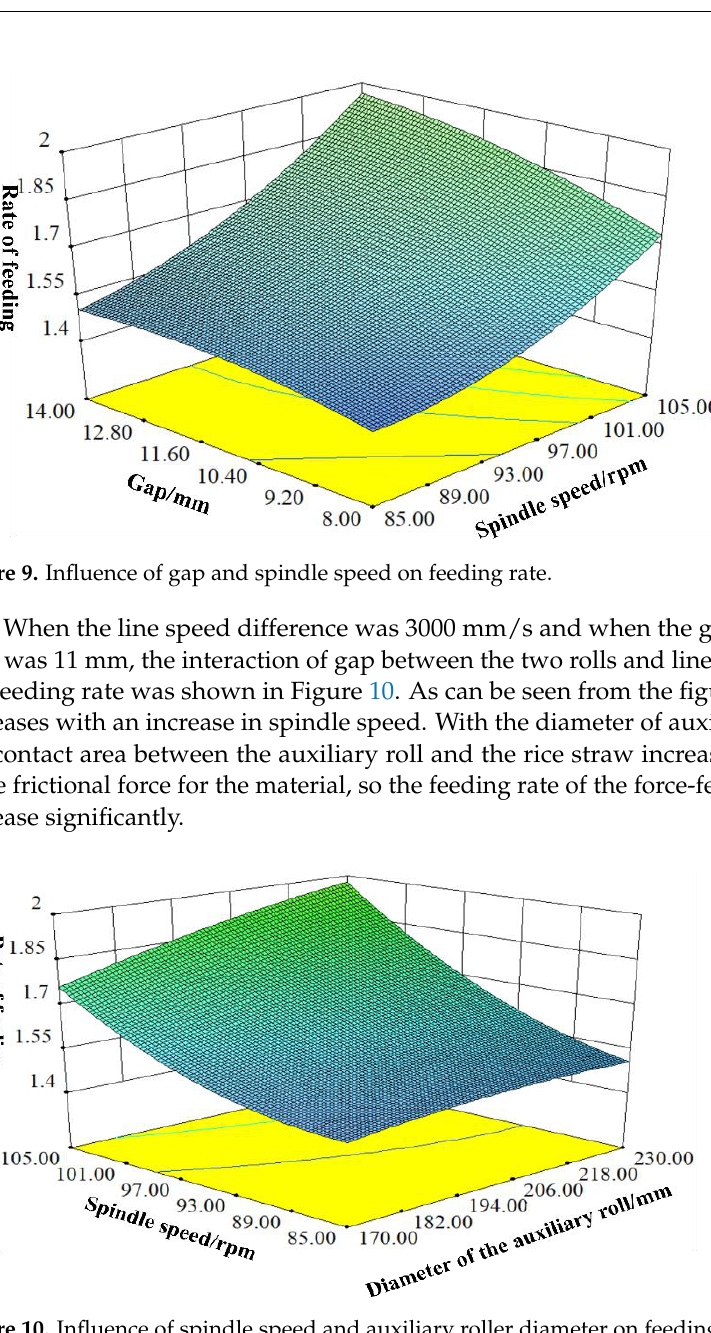
Figure 11. Influence of spindle speed and linear speed difference on feeding rate.